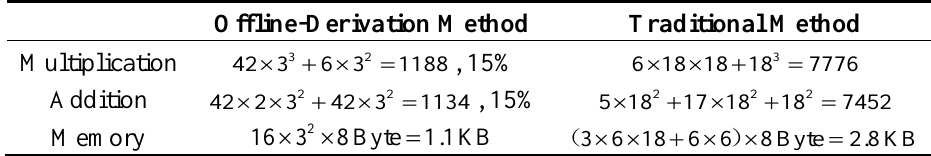
Table 6. Optimization efficiency of updating process.